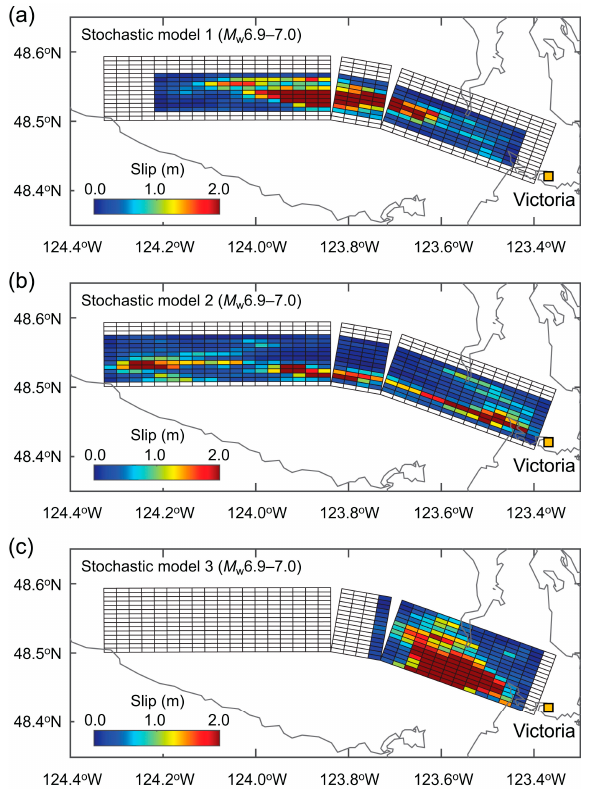
Figure 5. Three stochastic models ( a - c ) for the M w 6.9–7.0 scenario.